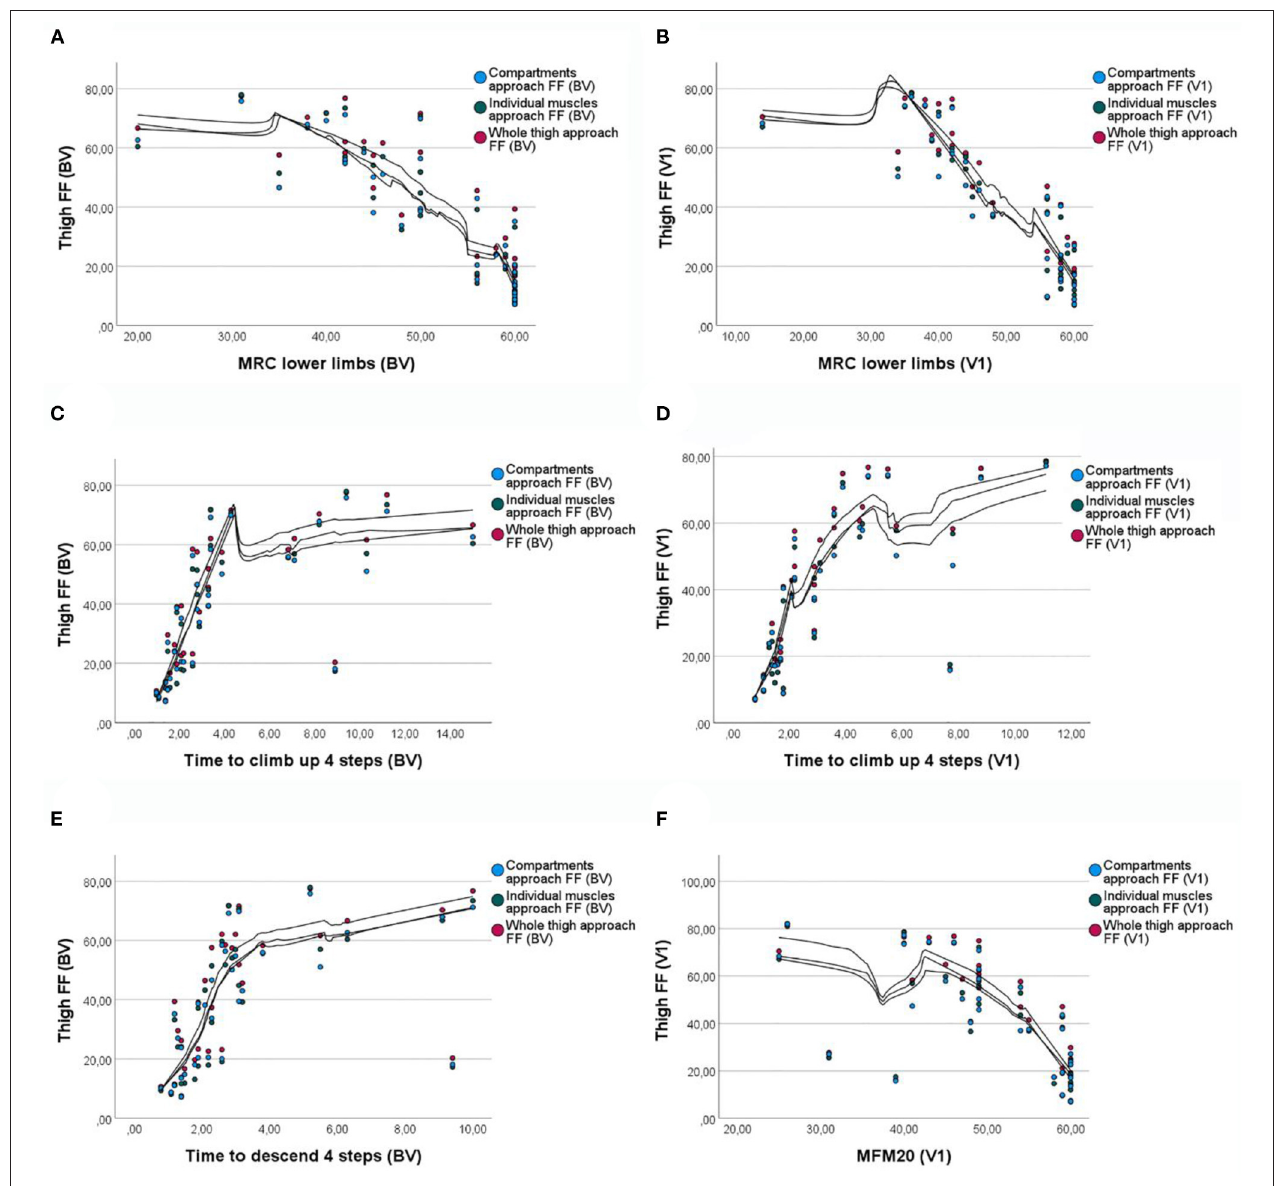
FIGURE 4 | Correlations between fat fraction and muscle function tests with the three approaches. (A) Correlation between MRC in lower limbs and FF at baseline. (B) Correlation between MRC in lower limbs and FF at visit 1. (C) Correlation between the time to climb four steps test and FF at baseline. (D) Correlation between the time to climb four steps test and FF at visit 1. (E) Correlation between the time to descend four steps test and the FF at baseline. (F) Correlation between the MFM20 and FF at visit 1. FF, fat fraction; BV, baseline visit; V1, visit 1; MRC, Muscle Research Council scale; MFM20, motor function measure − 20-item